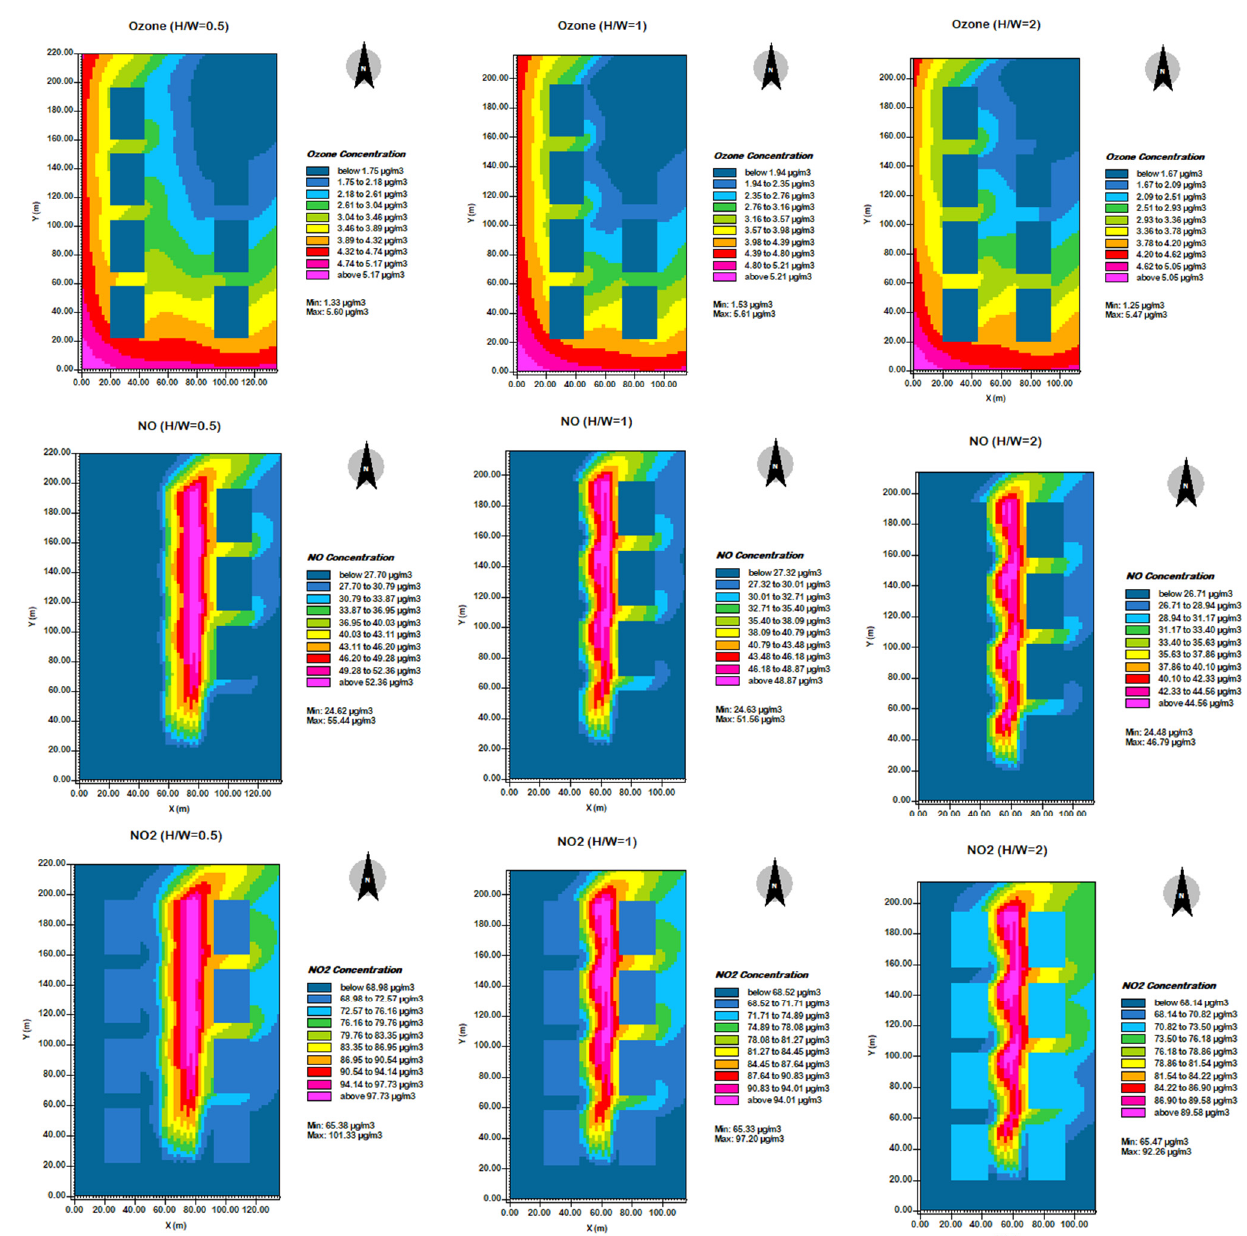
Figure 5. O 3 , NO, and NO 2 distribution at 1.5 m height in street canyons with AR = 0.5, 1, and 2 at at 2:00 2:00 p.m.